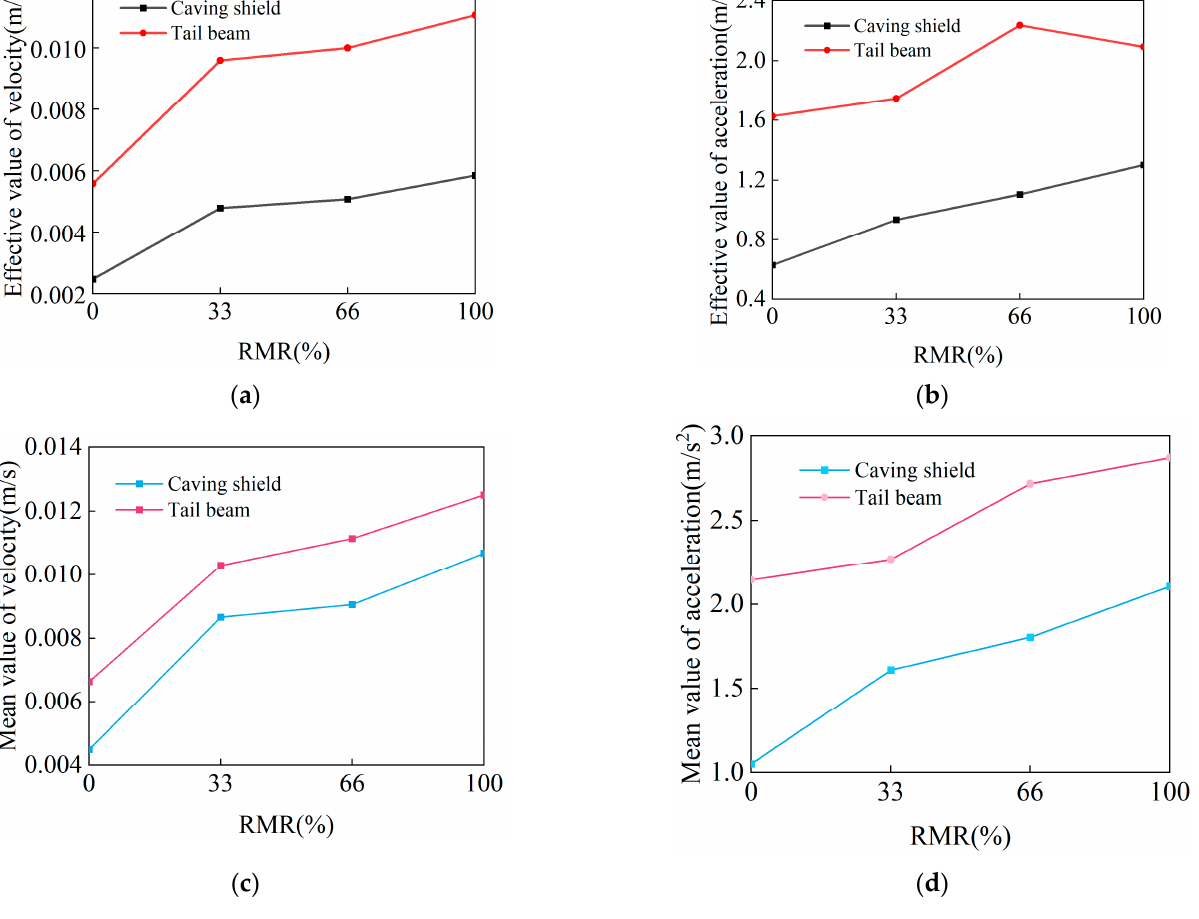
Figure 14. Vibration response of caving shield and tail beam under the slip ( a ) RMR versus effective value of velocity. ( b ) RMR versus effective value of acceleration. ( c ) RMR versus mean value of velocity. ( d ) RMR versus mean value of acceleration.